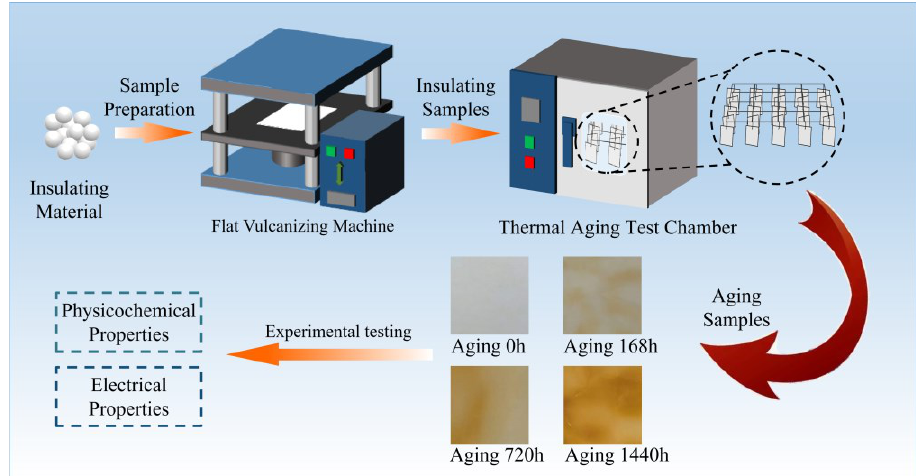
Figure 1. XLPE insulation layer preparation and thermal aging flowchart.